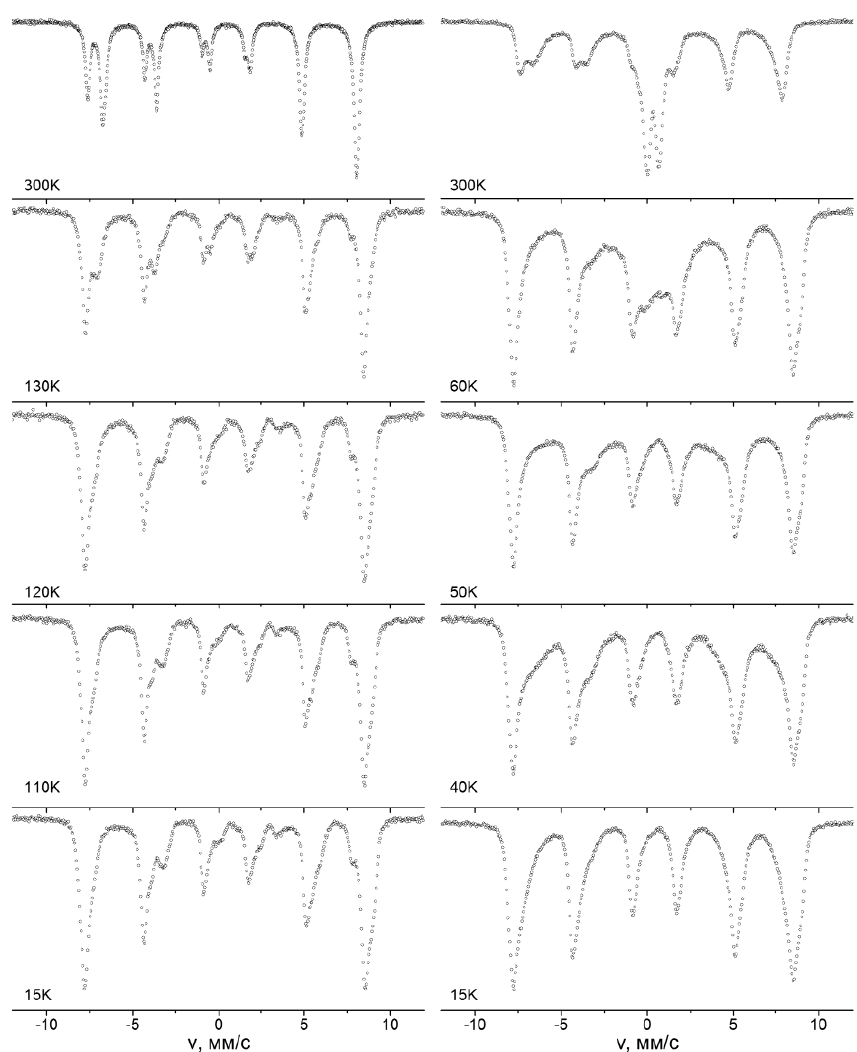
Figure 7. Mössbauer spectra of samples of Fe 3 O 4 nanoparticles in the vicinity of the Verwey transition. The left column spectra of the particle sample d ≈ 32 nm, the right column spectra of the particle sample d ≈ 13 nm.